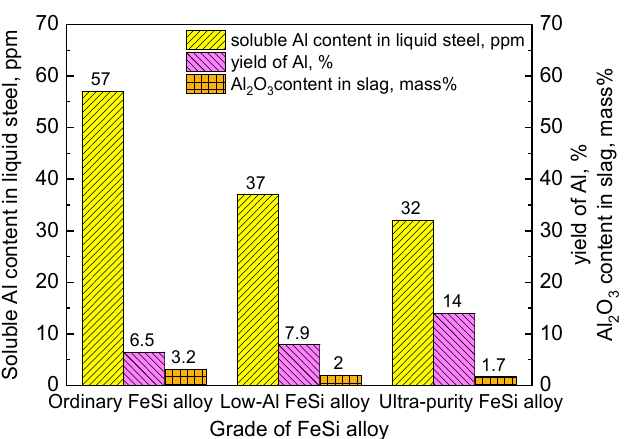
Figure 2. Comparison of Al content in molten steel and Al 2 O 3 content in slag when using different ferrosilicon alloys.